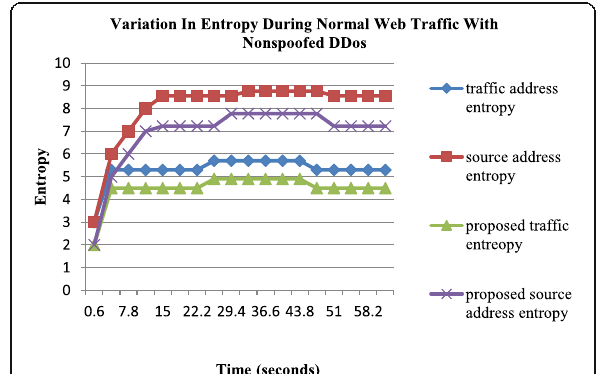
Fig. 8 Entropy variation between traffic address entropy and source address entropy are presented during web traffic reflecting the non- spoofed DDoS